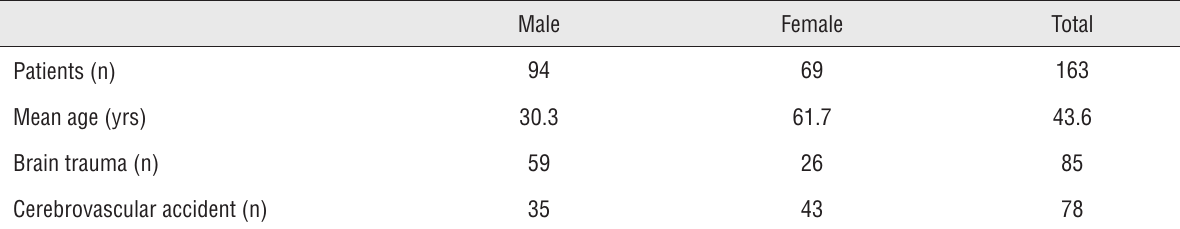
Table 1b - patient’s general